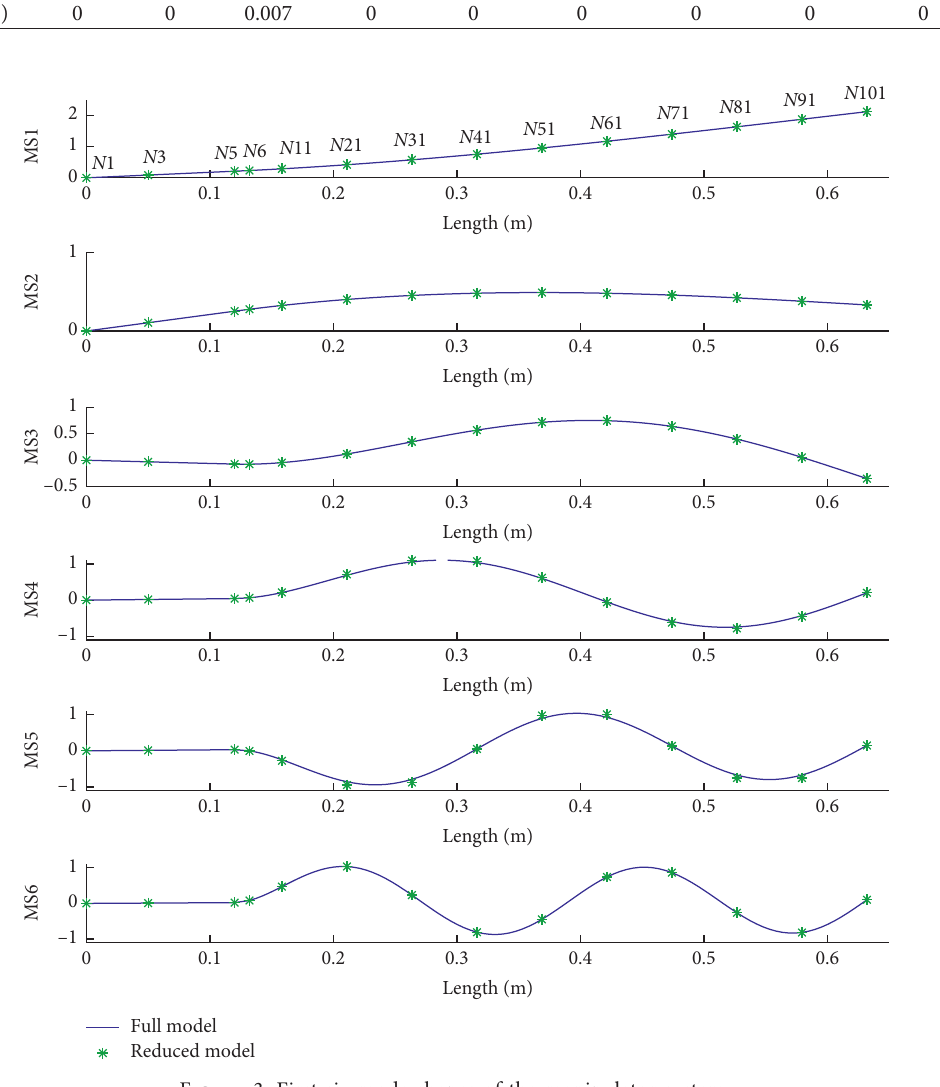
Figure 3: First six mode shapes of the manipulator system. Table 4: Natural frequencies of the rebuilt reduced model (RRM) compare the reduced model